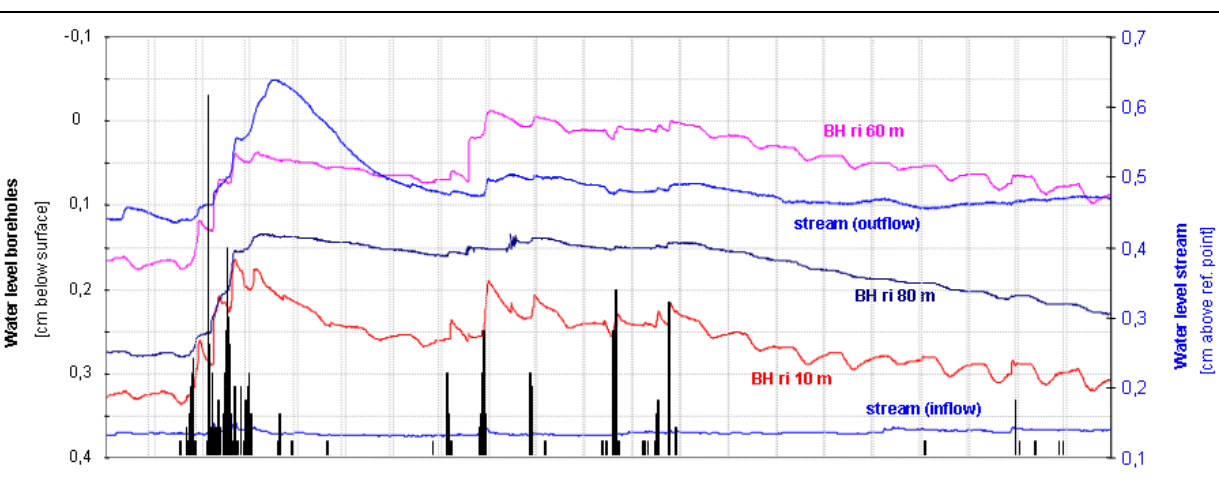
Figure 28. Changes in water level and EC in near-stream groundwater in response to the first spring rains (September